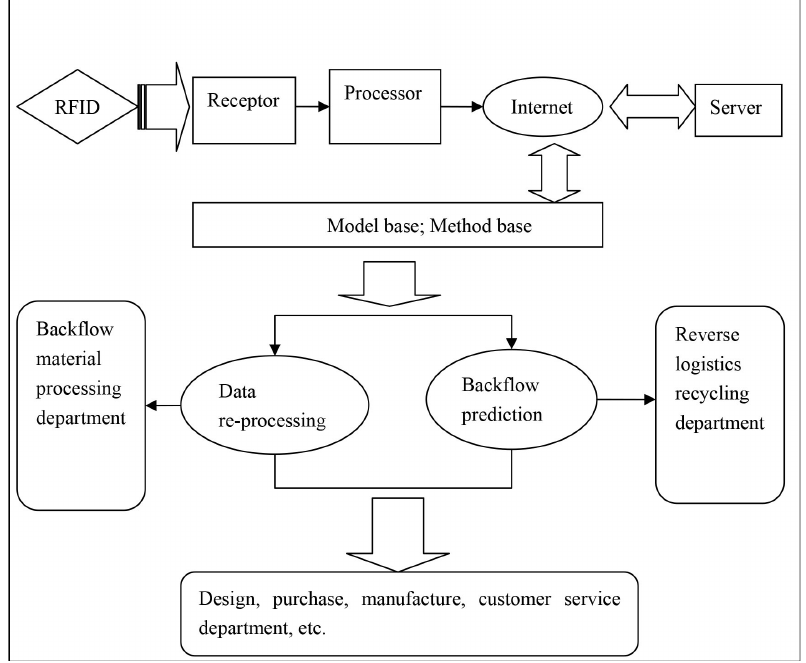
Figure 2. The information processing flow of the reverse logistics MIS based on the application of the Internet of Things